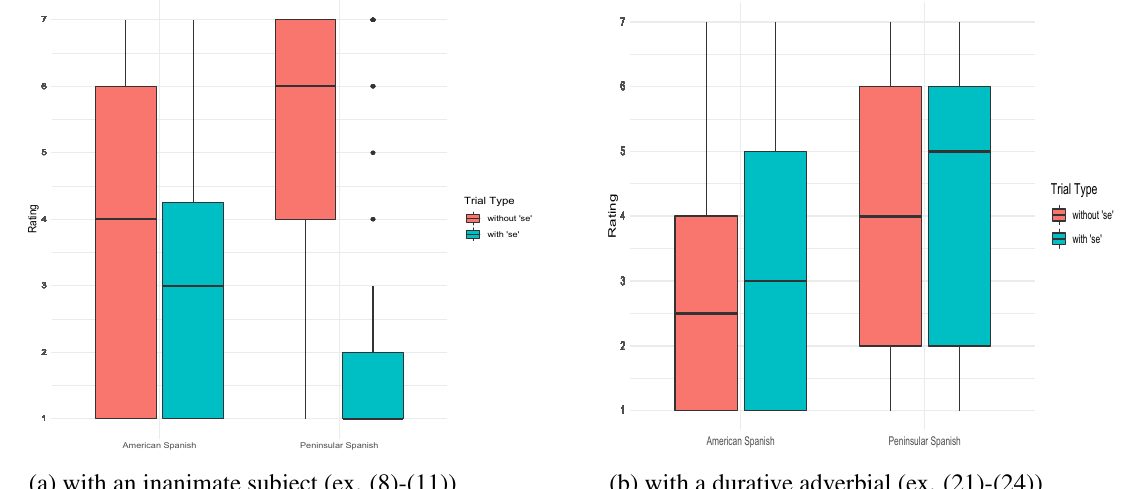
Figure 1. Results of the survey for sentences with comer with vs. without se (examples (8)-(11) and (21)-(24); 1 = completely acceptable, 7 = completely